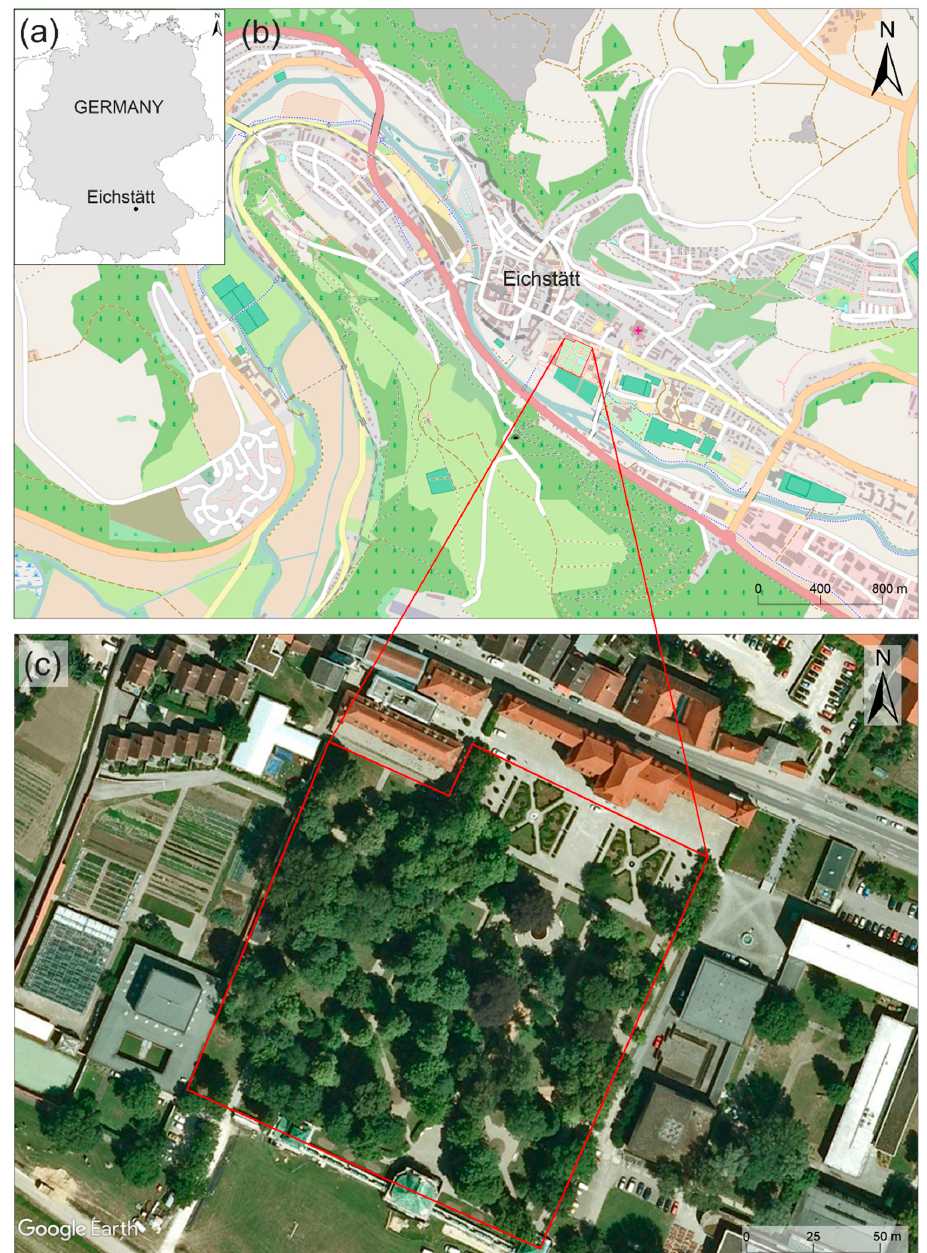
Figure 1. Location of the study site in Germany (Eurostat, NUTS 2013/EU-28) ( a ) and in the city of Eichstätt, red border; ( b ) OpenStreetMap; ( c ) GoogleEarth.